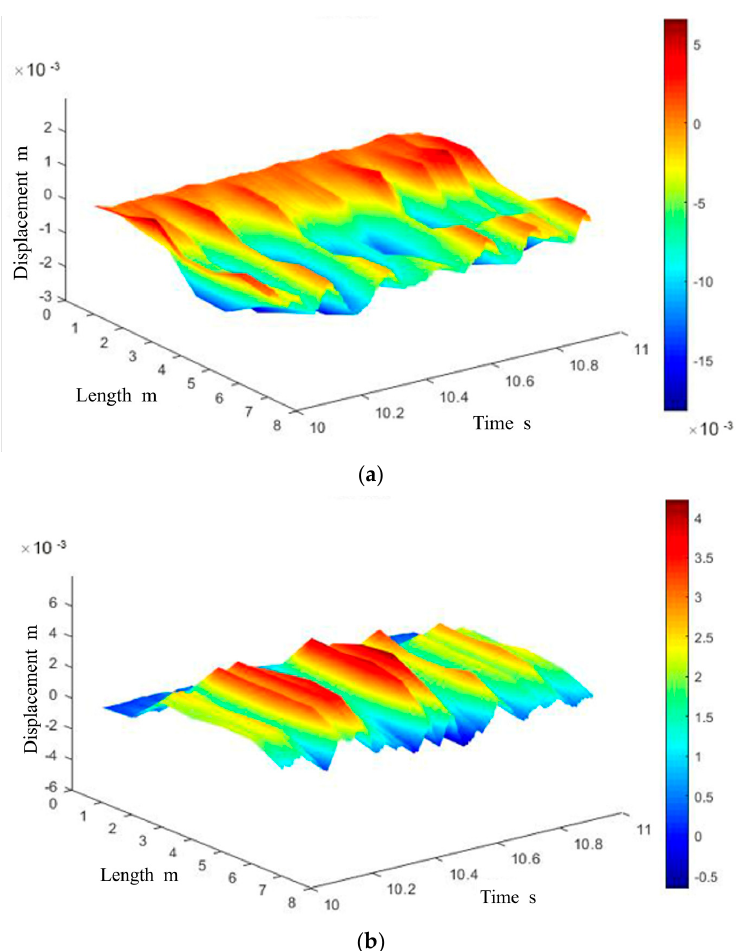
Figure 11. Cloud diagrams of the displacement characteristics of the leaching strings with a water injection rate of 72 L/min. ( a ) Direct circulation. ( b ) Reverse circulation.